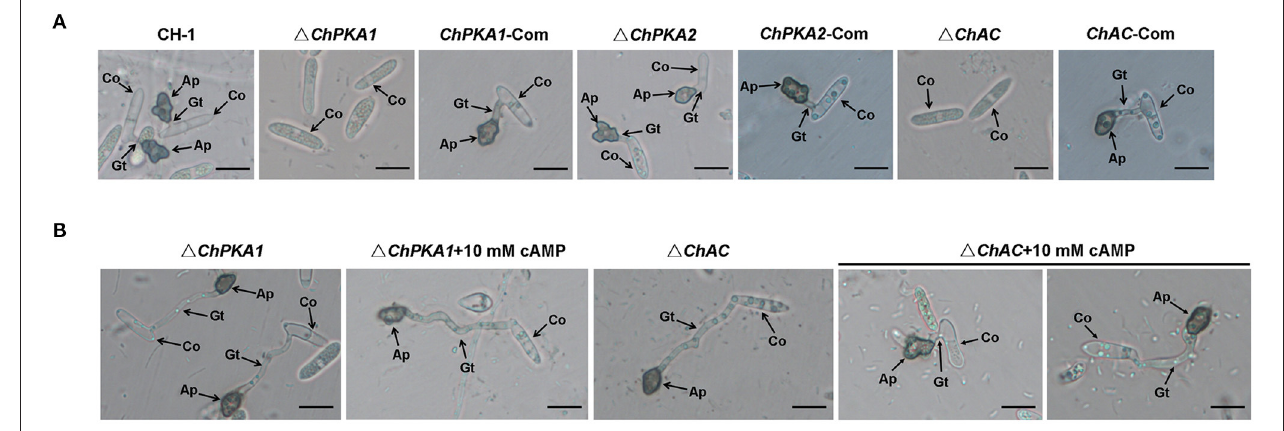
FIGURE 5 | The appressorial development of indicated strains on hydrophobic coverslips. (A) The development of appressoria on plastic microscopic coverslips at 25 ◦ C for 24 h. Conidial density was 10 6 conidia/ml. (B) Appressorial formation on plastic microscopic coverslips at 25 ◦ C for 24h, with or without exogenous 10mM cAMP. Conidial density was 10 4 conidia/ml. The images were taken by using Nikon Eclipse 80i microscope (Nikon, Tokyo, Japan), under bright-field model with 40 × fold magnification. Ap, appressoria; Co, conidia; Gt, germ tubes. Bars = 10 µ m.